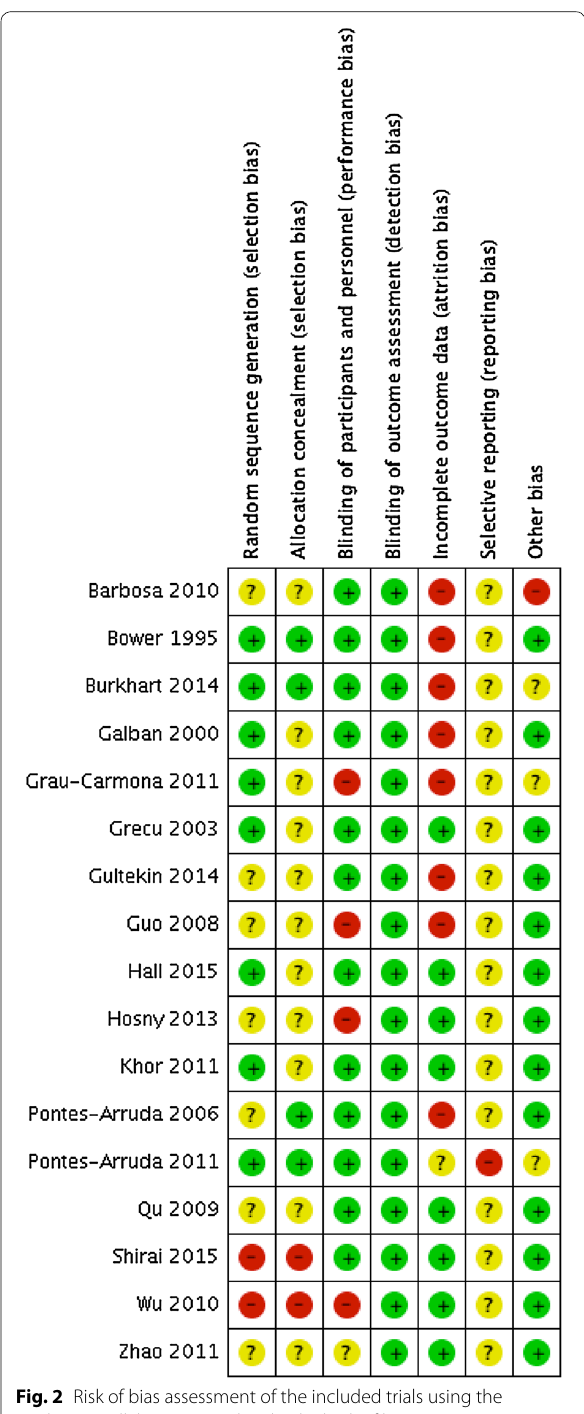
Fig. 2 Risk of bias assessment of the included trials using the Cochrane Collaboration tool. Individual risk of bias assessments across seven domains: random sequence generation, allocation conceal- ment, blinding of participants and personnel, blinding of outcome assessment, incomplete outcome data, selective reporting, and other bias. Risk of bias levels: low ( green ), unclear ( yellow ), high ( red